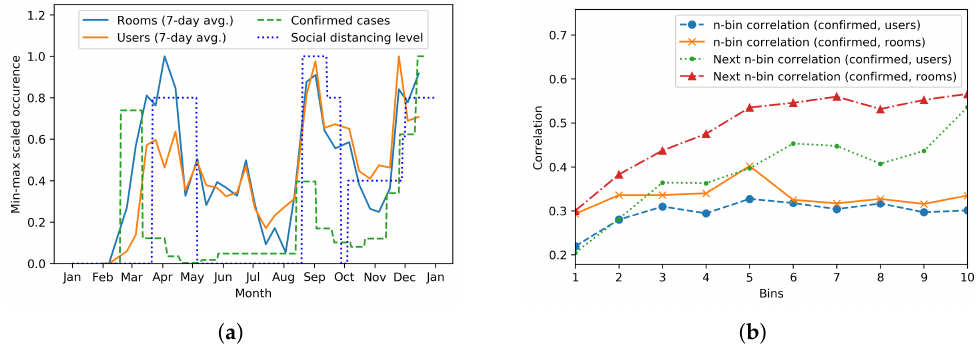
Figure 6. Statistics regarding number of rooms, users, and confirmed cases. ( a ) Rooms, users, and confirmed cases of COVID-19; ( b ) Correlation among rooms, users, and confirmed cases of COVID-19.